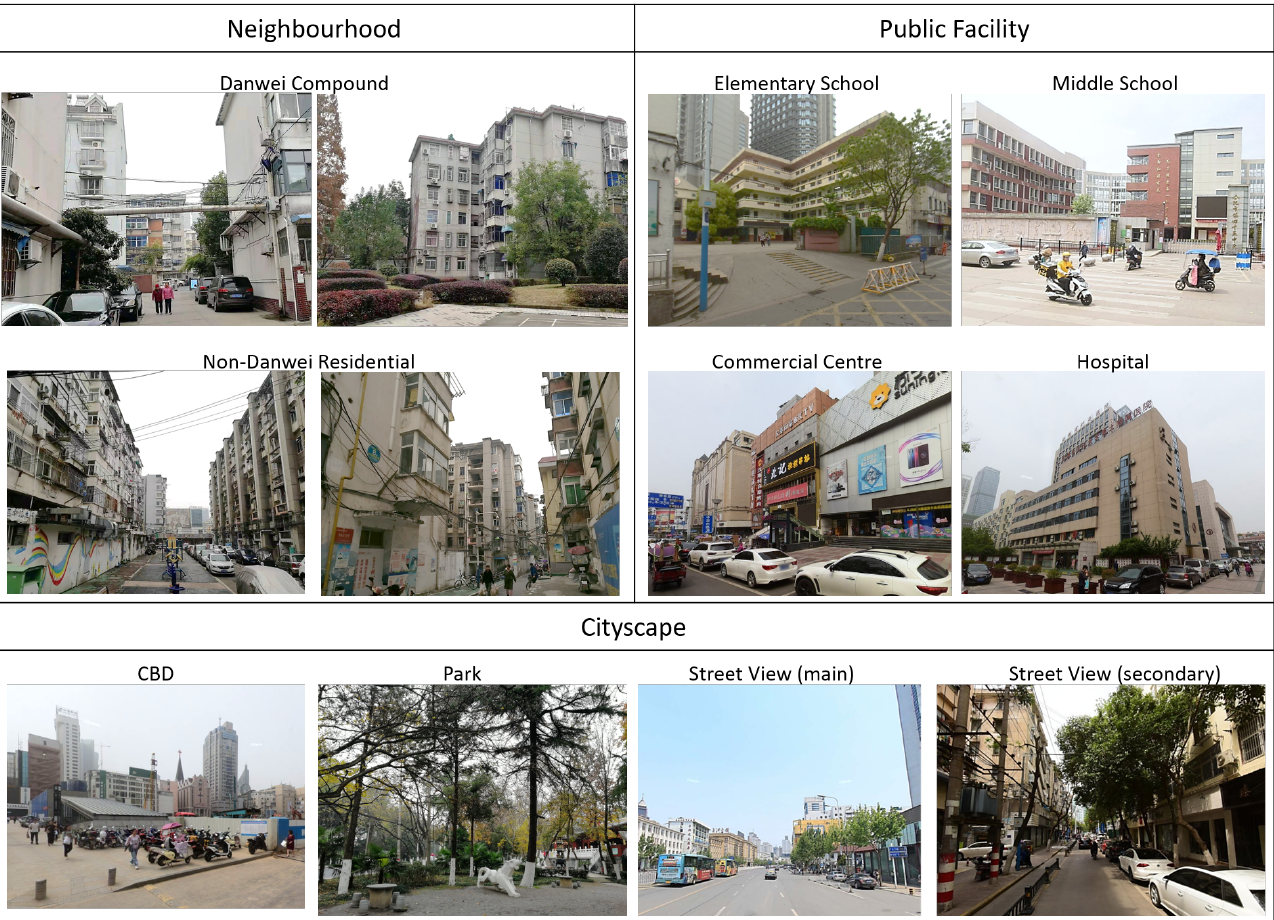
Figure 4. Photos of Hefei Old Town (Photo Source: By the Author, Baidu Map